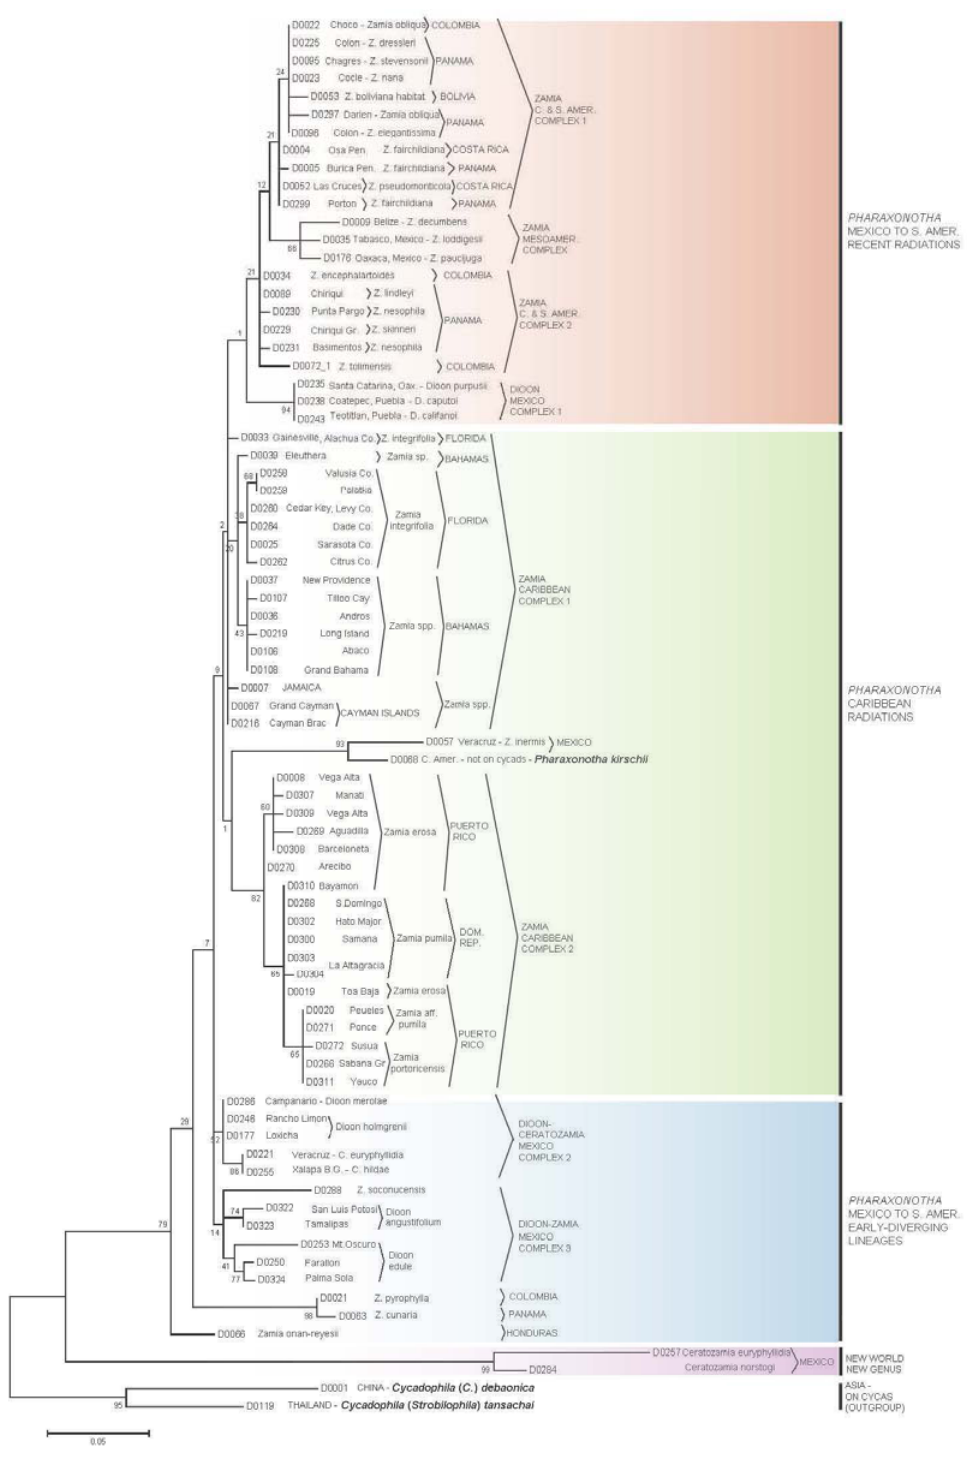
Figure 4. Phylogenetic tree for the Erotylidae: Pharaxonothinae on the cycads of the New World based on maximum likelihood analysis of 16S rRNA gene sequences; scale bar indicates base pair substitutions per nucleotide position; numbers on branches are bootstrap values.